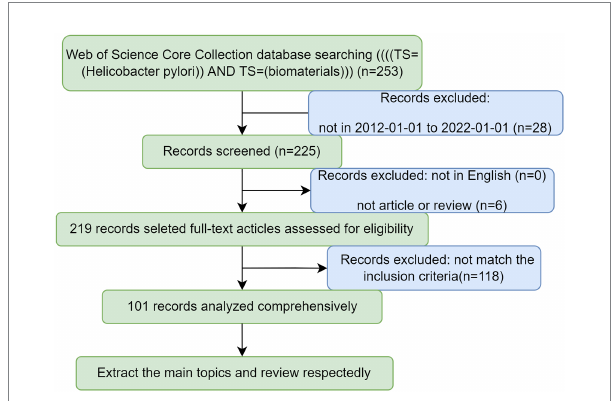
FIGURE 1 Flow charts of search strategies and filtering methods.